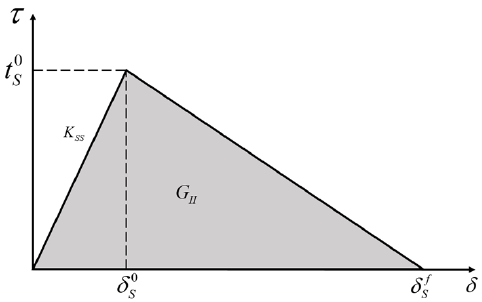
Figure 5. Traction–separation law with linear softening available in ABAQUS ® [45]. Table 1. Parameters of the traction–separation behaviour for the cohesive elements to model the adhesive layer [45].